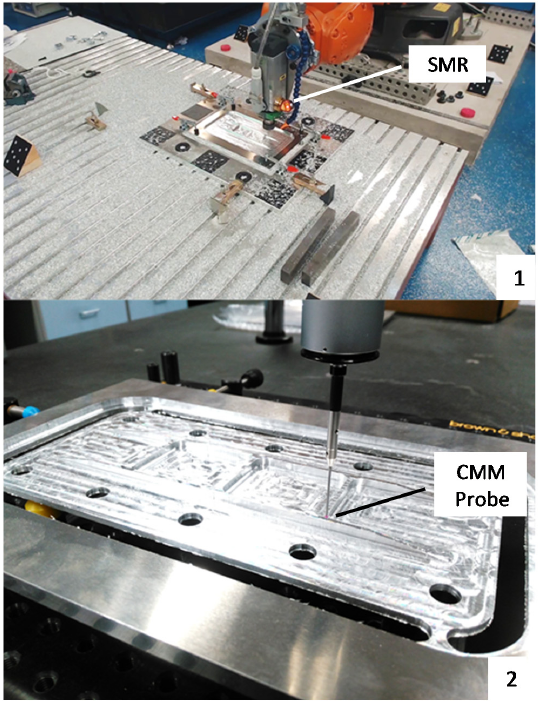
Figure 26. ( 1 ) Machining of the part and ( 2 ) CMM measurement of the finished part.